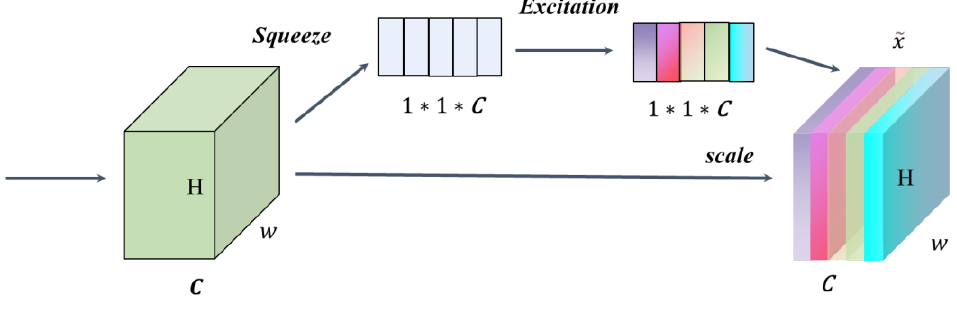
Figure 8. Structure of the SE.